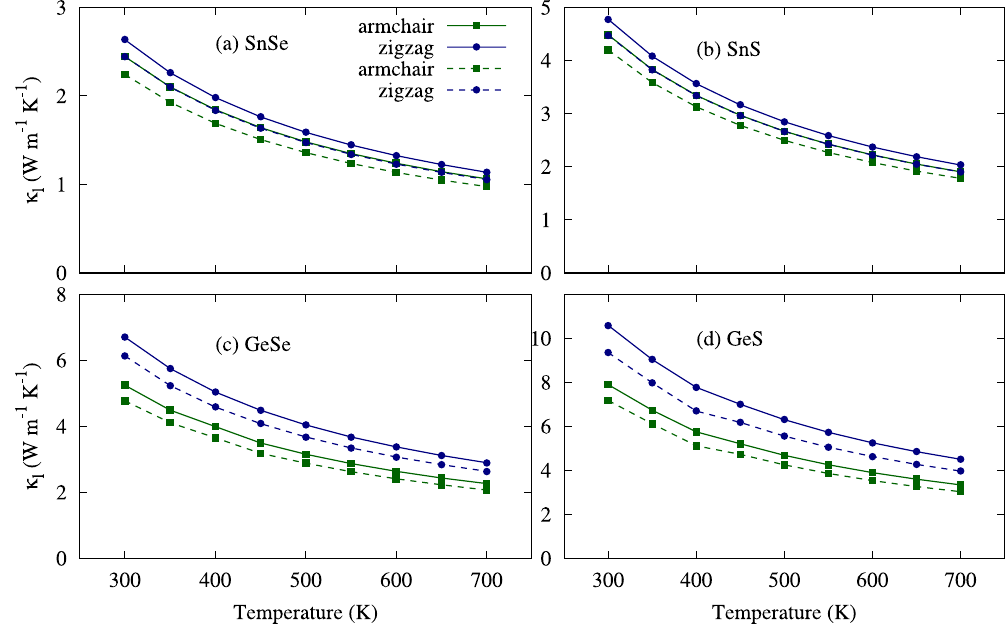
Figure 6. Lattice thermal conductivity ( κ l ) for the group IV–VI monolayers are calculated as a function of the temperature using iterative (solid lines) and SMRTA (dashed lines) method.